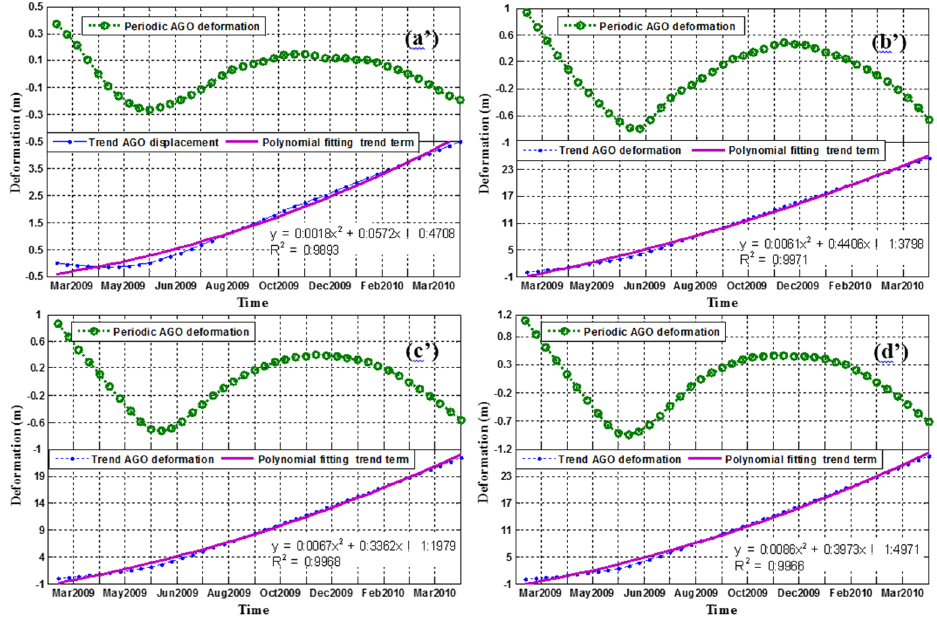
Figure 11. The decomposition results of CR2 and CR14 using accumulated generating operation; ( a’ , b’ ) are range and azimuth results of CR2; ( c’ , d’ ) are range and azimuth results of CR14.